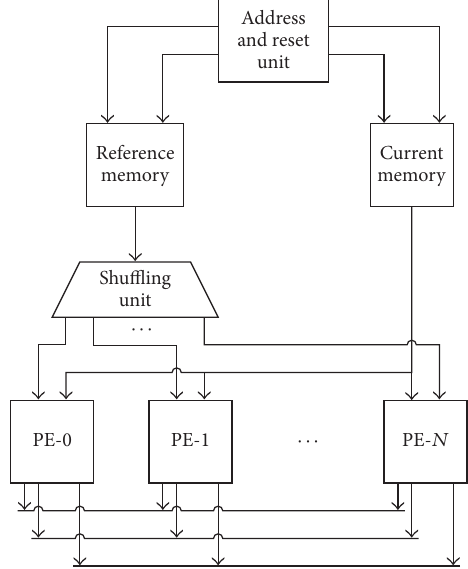
Figure 5: Proposed hardware implementation of VBSME.